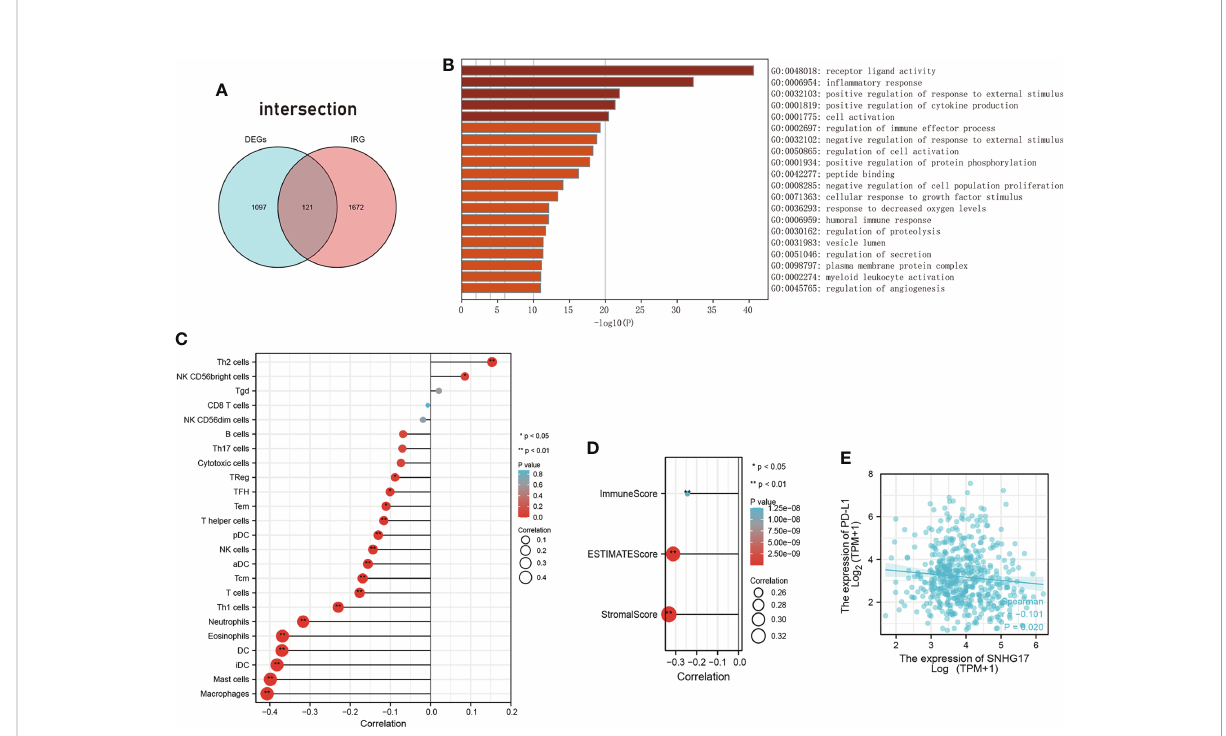
FIGURE 4 The relationship between SNHG17 and immune. (A) Venn diagram visualizing the overleaping genes between DEGs and IRGs. (B) Summary of enrichment analysis across input the intersected genes of DEGs with IRGs. (C) The correlation between SNHG17 and immune cell in fi ltration, respectively. (D) Correlation analysis between SNHG17 and immune-related scores (ESTIMATEScore, ImmuneScore, StromalScore). (E) Correlation analysis between SNHG17 and PD-L1 expression. DEGs, Differentially expressed genes; IRGs, Immunity-related genes; PD-L1, Programmed death ligand